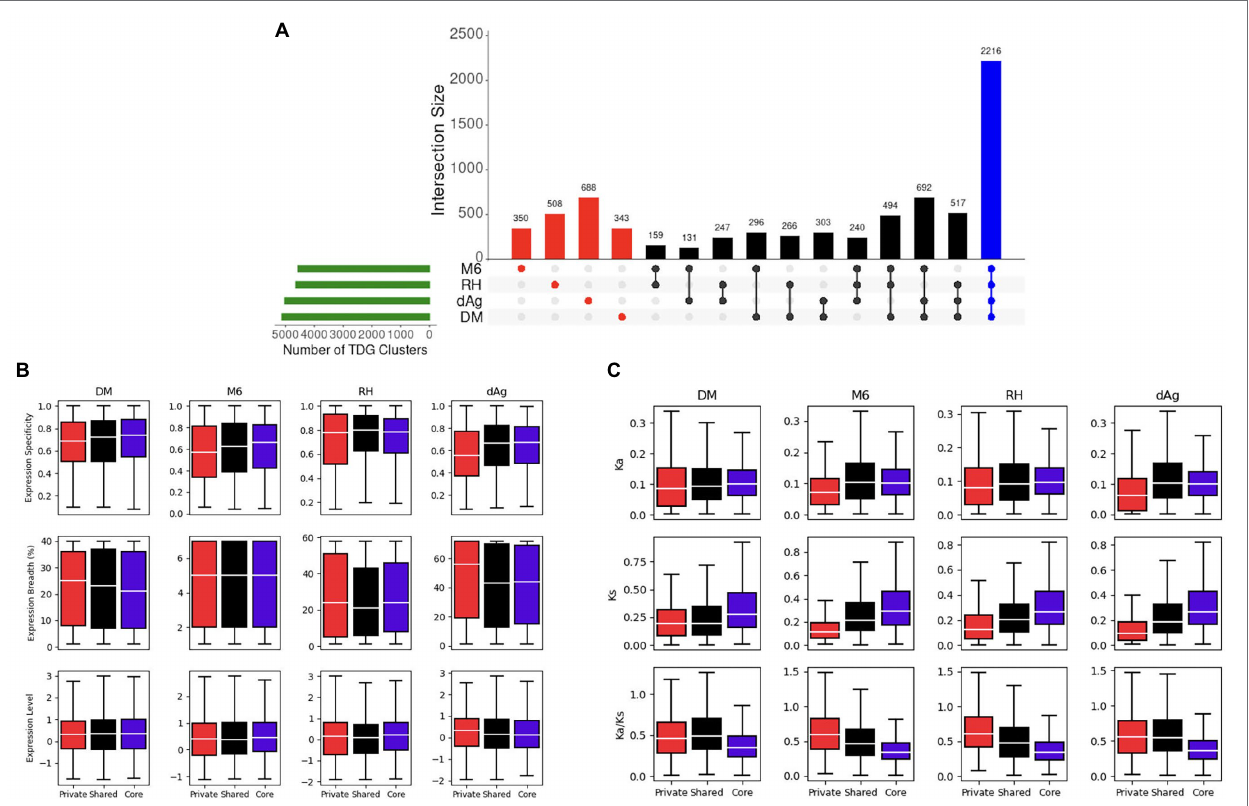
FIGURE 9 | (A) Distribution of Private (Red), Shared (Black), and Core (Blue). Tandemly duplicated clusters across potato genomes via orthogroups. (B) Expression patterns of private, shared, and core TDG clusters. (C) Evolutionary patterns of private, shared, and core TDG clusters.